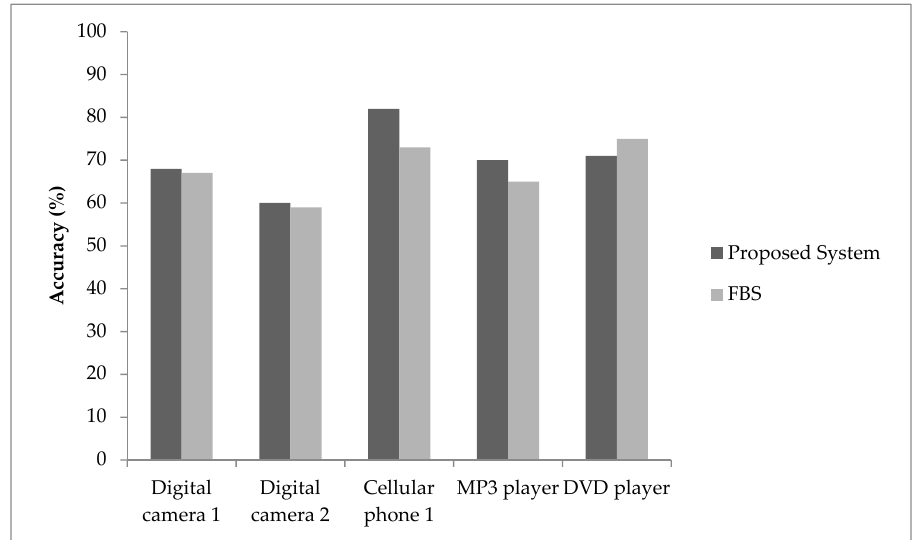
Figure 14. Comparison of average accuracy FBS and proposed system.